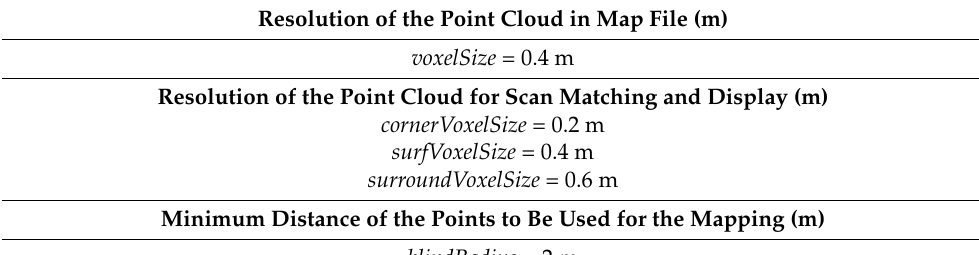
Figure 7. Kaarta Stencil 2–16 wearable mobile mapping system used: main components and a photo taken during the data acquisition. Table 2. Setting Kaarta Stencil 2 parameters input for outdoor